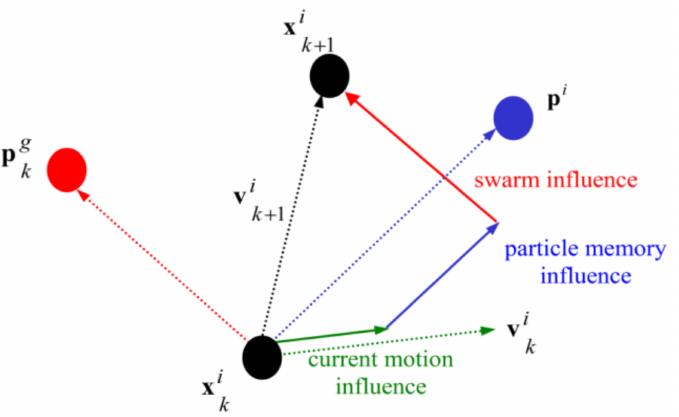
Figure 7. Updating the position of particles in PSO.